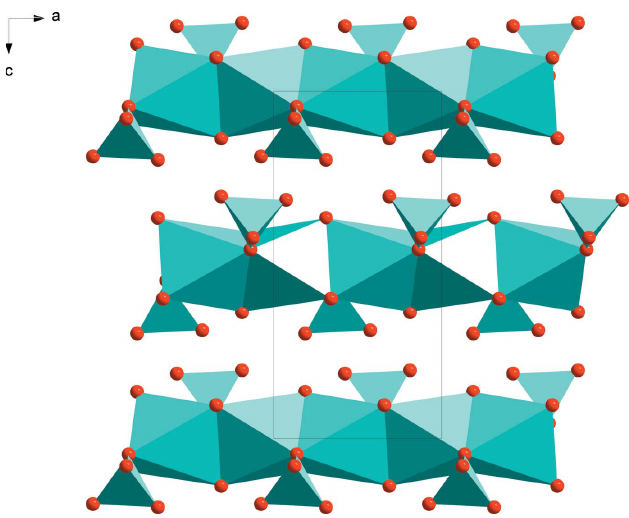
Figure 1 Section of the crystal structure of SASD, viewed approximately along the Figure 2 c- axis direction towards the origin. Displacement ellipsoids are drawn at the 50% probability level. Hydrogen atoms are represented by small The crystal structure of SASD viewed down the b -axis direction, showing spheres of arbitrary radius. Thick dashed lines represent hydrogen bonds. the chains featuring face-sharing NaO 6 octahedra with appended SO 4 [Symmetry codes: (i) x + 1 tetrahedra. Ammonium ions are omitted for clarity. , (cid:4) y + 3 , (cid:4) z + 1; (ii) x (cid:4) 1 , (cid:4) y + 3 , (cid:4) z + 2 2 2 2